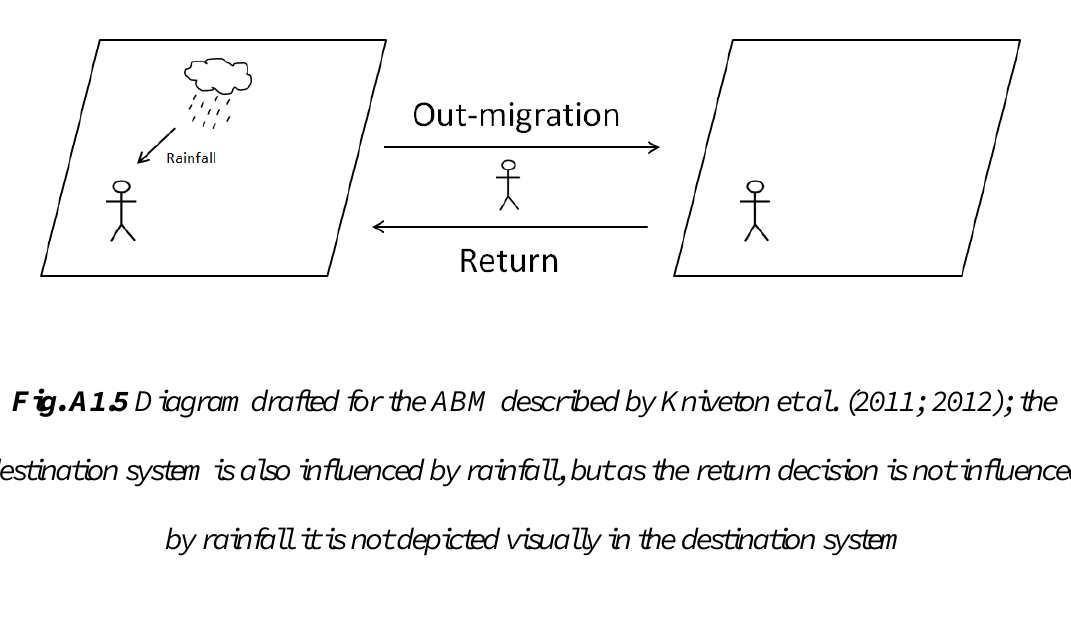
Table A1.5 Standardized protocol for the ABM described by Kniveton et al. (2011;